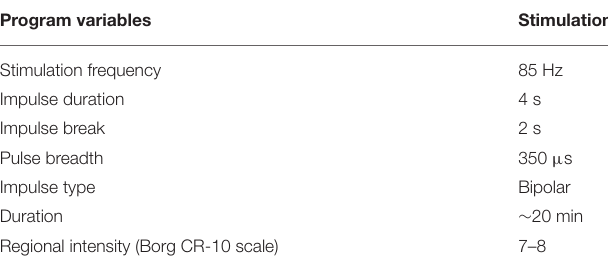
TABLE 1 | Whole body electrostimulation protocol